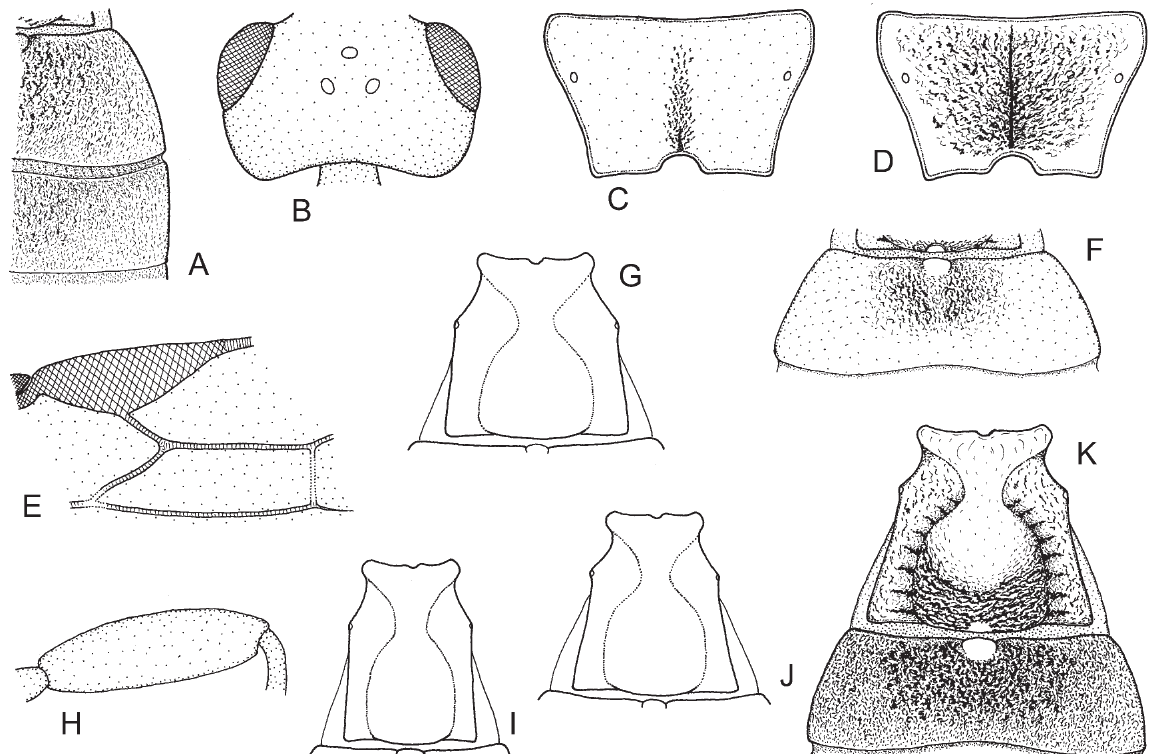
Fig. 20. — A-J . Bracon ( Bracon ) longicollis Wesmael, 1838 (A: ♂ paralectotype, B-E, G: ♀, F: ♀/♂, H-J: ♂). A . Right half of tergites 2-3. B . Head in dorsal view. C-D . Propodeum. E . Middle part of forewing: pterostigma and second submarginal cell. F . Second tergite. G . First tergite. H . Hind femur. I-J . First tergite. — K . Bracon ( Bracon ) longicollis var . depressiusculus (Wesmael, 1838), tergites